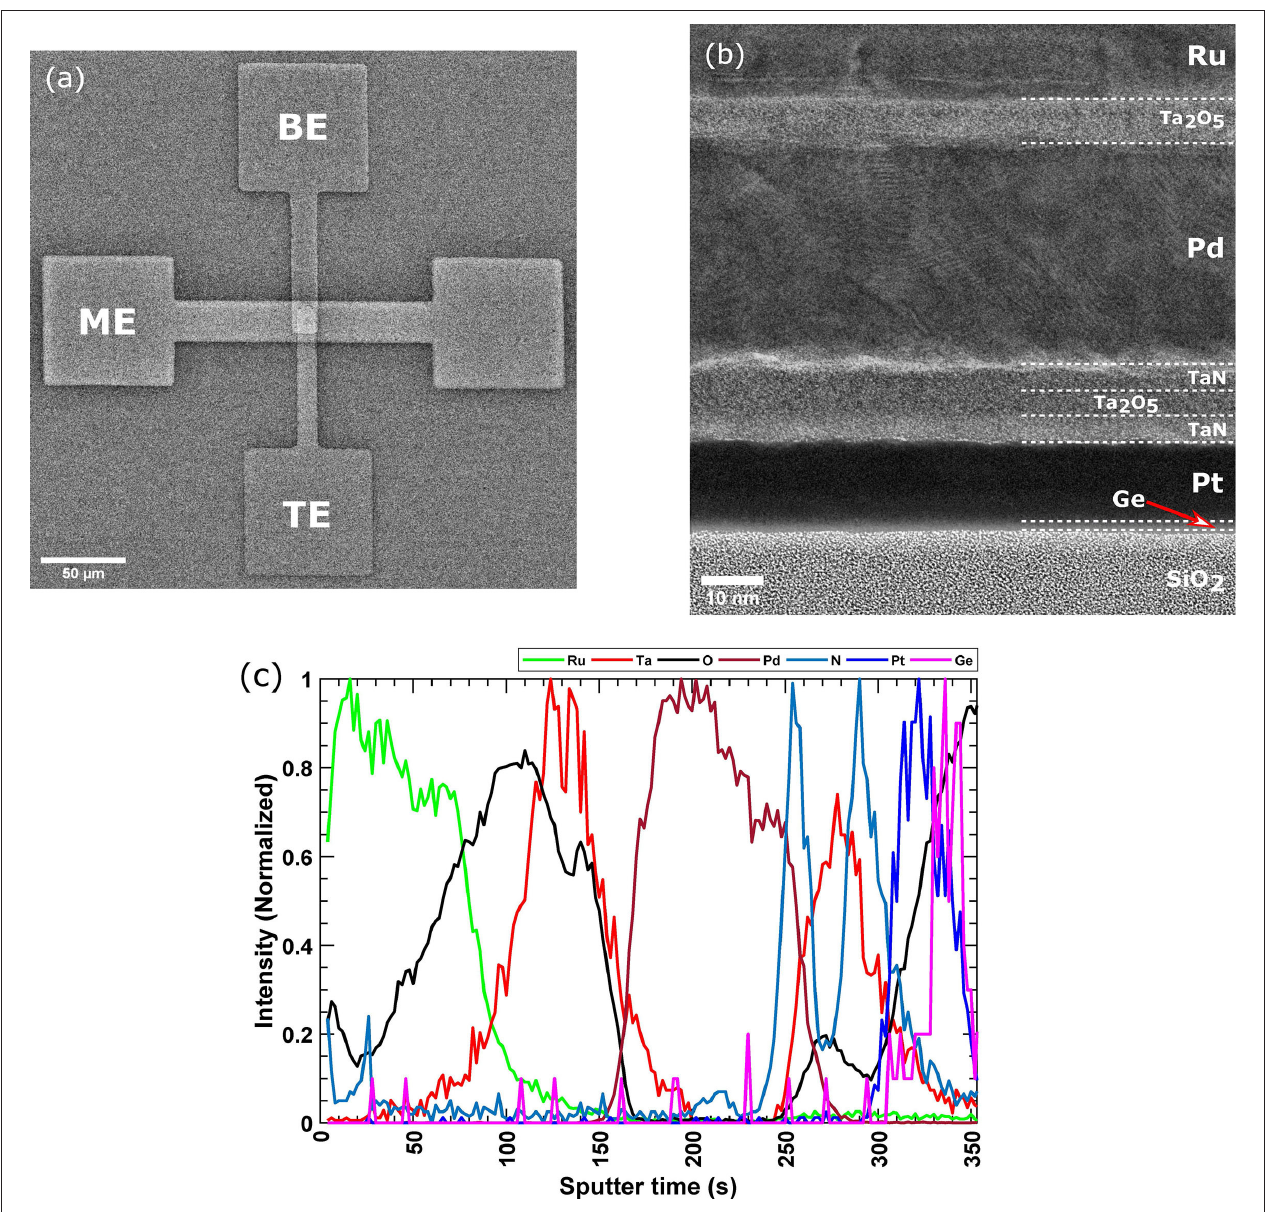
FIGURE 5 | Physical characterization of the vertically integrated 1S1R cell. (a) Scanning electron microscopy image of the 1S1R cell showing the top view of the device. (b) Cross-sectional STEM image of the 1S1R cell. (c) ToF-SIMS depth profile through the layers of the vertically integrated 1S1R cell.